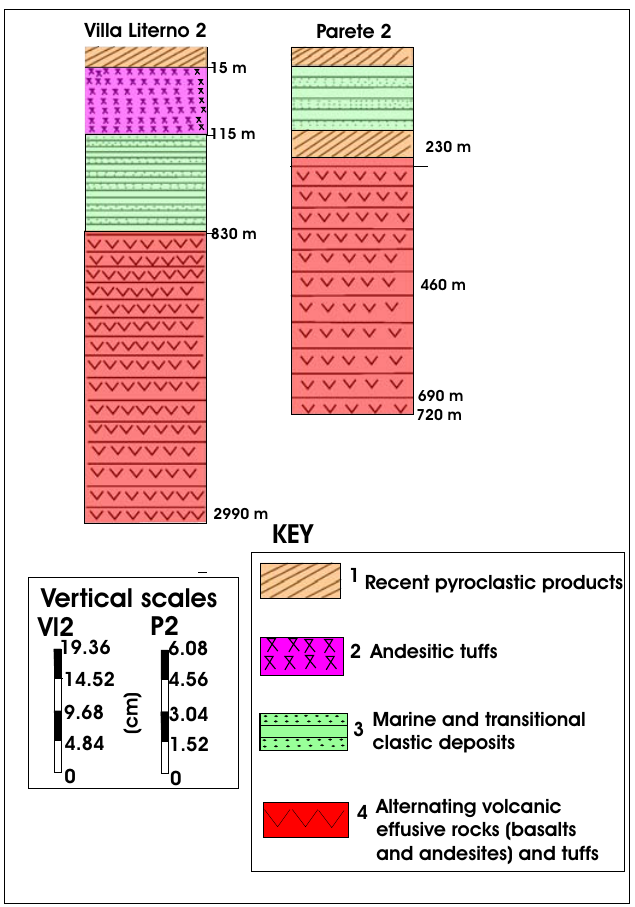
Figure 4. Schematic stratigraphy of the «Villa Literno 2» and «Parete 2» lithostratigraphic wells (modified from Ortolani and Aprile